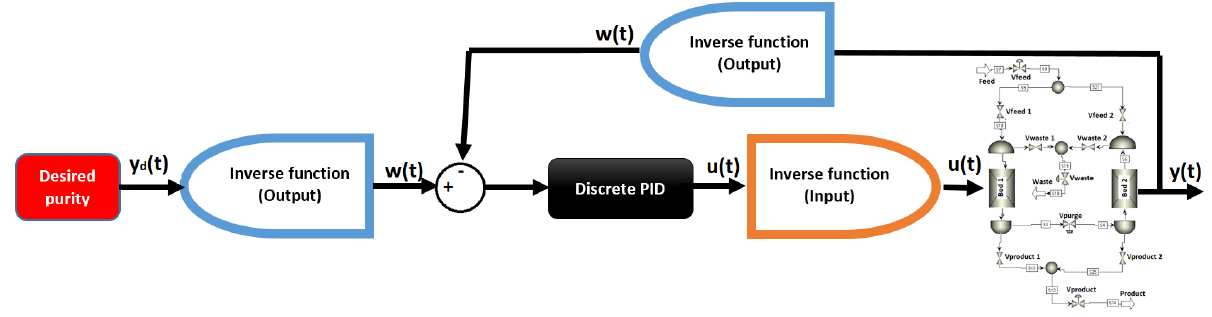
Figure 16. Discrete PID control implementation for the PSA